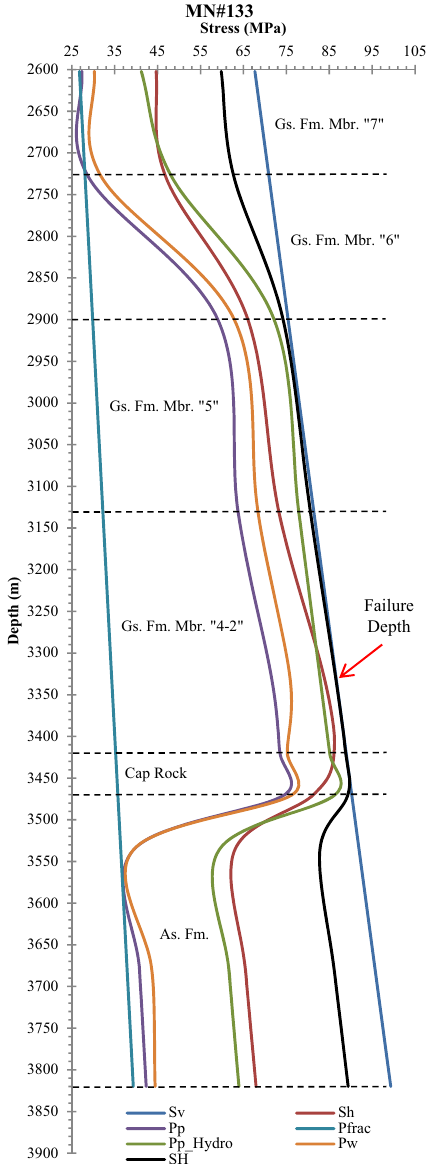
Fig. 5 In situ stress determined for Marun 130 well Fig. 6 In situ stress determined for Marun 133